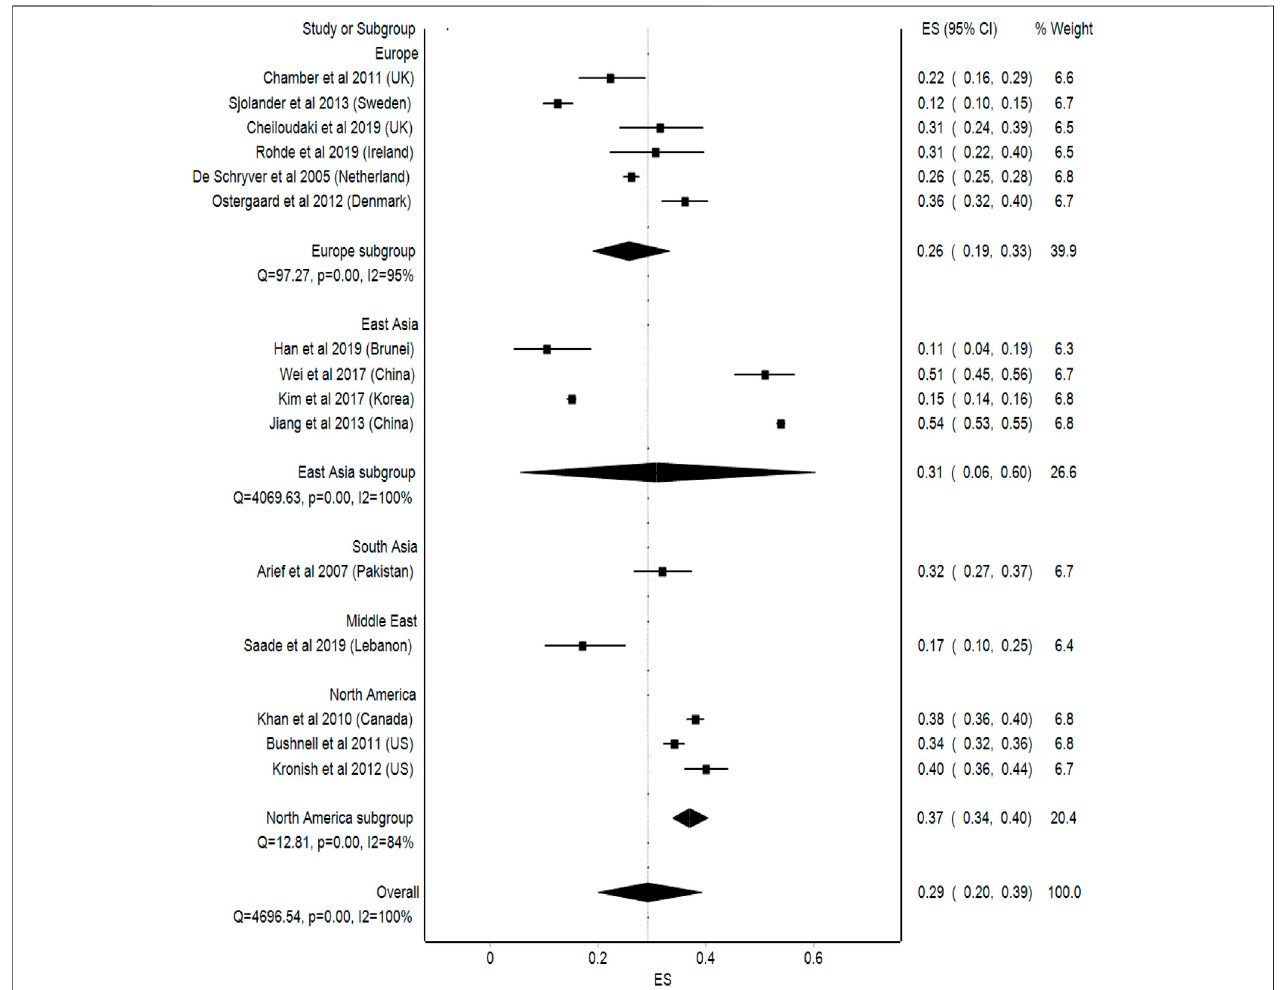
FIGURE 7 | Meta-analysis of medication non-adherence by